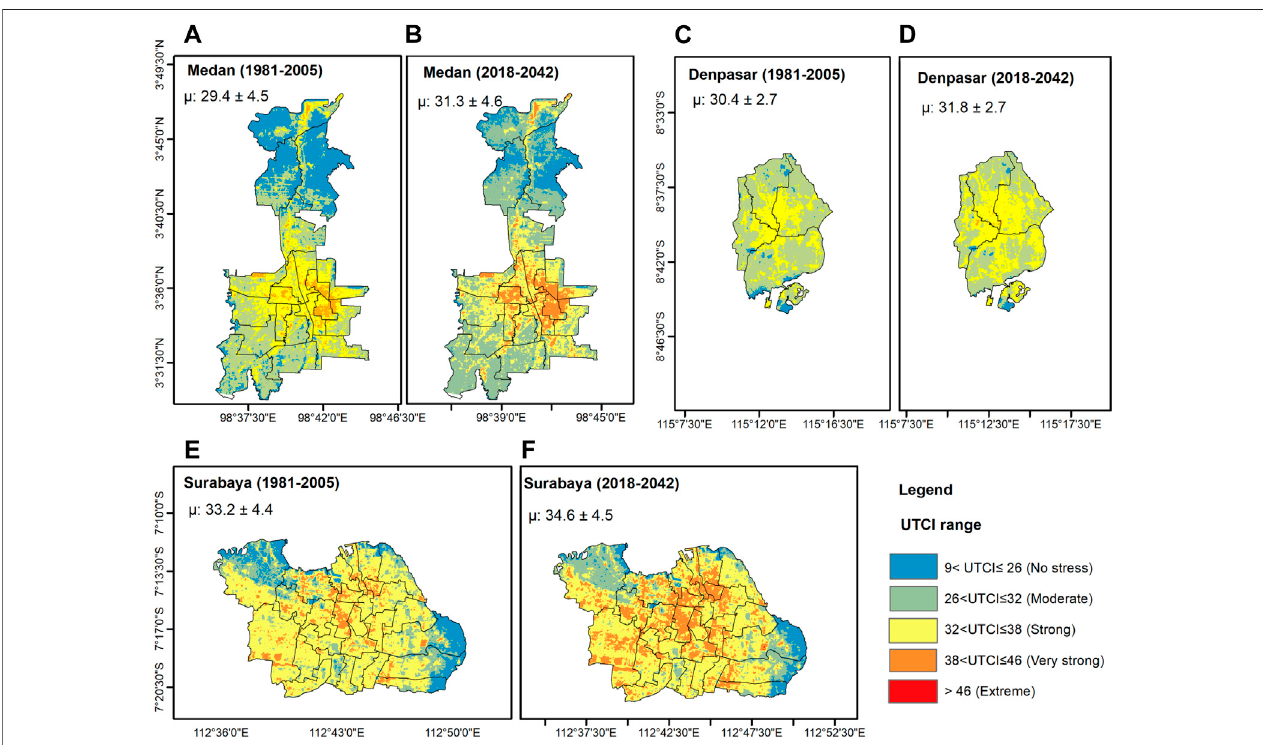
FIGURE 8 | UTCI spatial distribution in Medan, Denpasar, and Surabaya, ensemble mean CC scenario. The (A, C, E) refer to the baseline period of Medan, Denpasar, and Surabaya, while (B, D, F) are the future period of Medan, Denpasar, and Surabaya under the ensemble mean CC scenario.